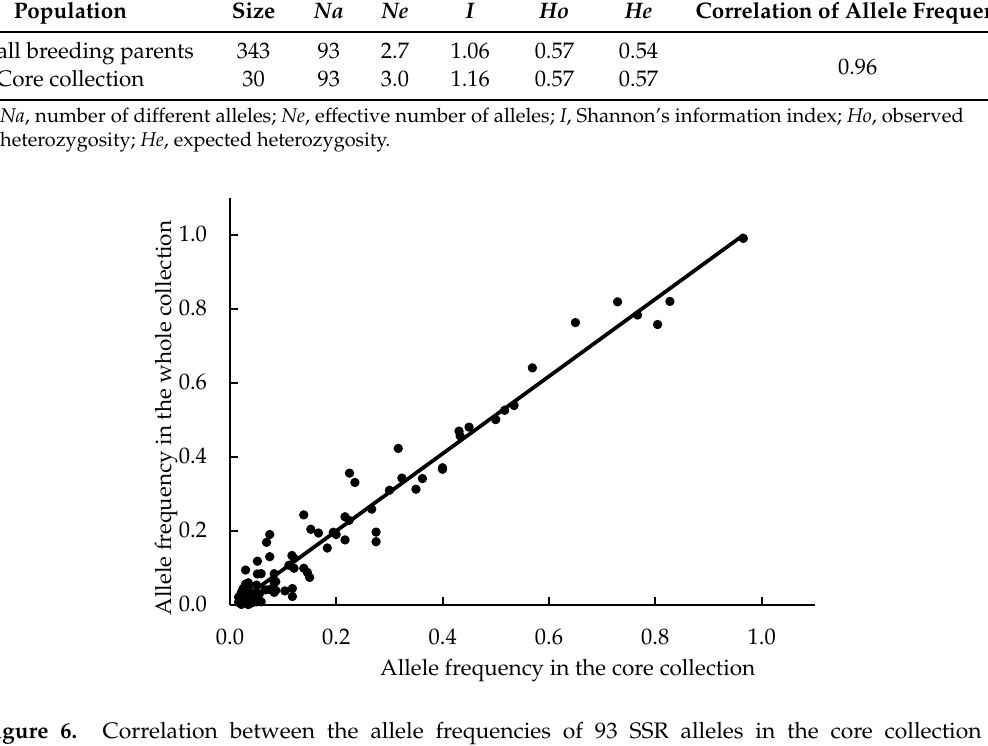
Table 6. SSR diversity within the core collection compared with the overall breeding parents.